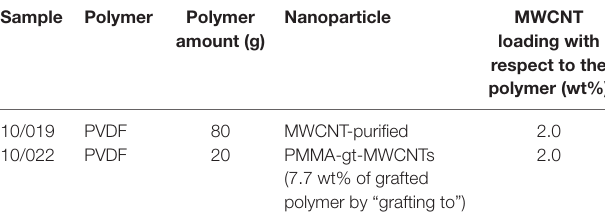
TaBle 3 | Details of the membranes